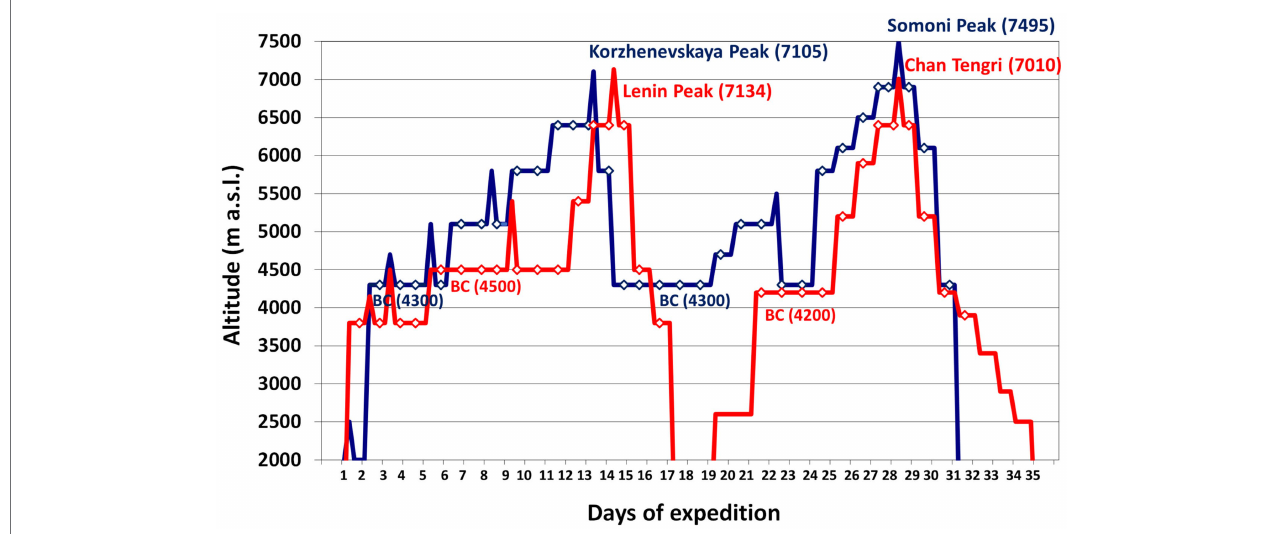
FIGURE 1 | The rate of ascent of the expeditions we analyzed. Legend: red line – Kyrgyzstan expedition to Lenin Peak (7,134 m) and Chan Tengri (7,010 m); blue line – Tajikistan expedition to Korzhenevskaya Peak (7,105 m) and Somoni Peak (7,495 m); diamonds – sleeping altitude. BC, base